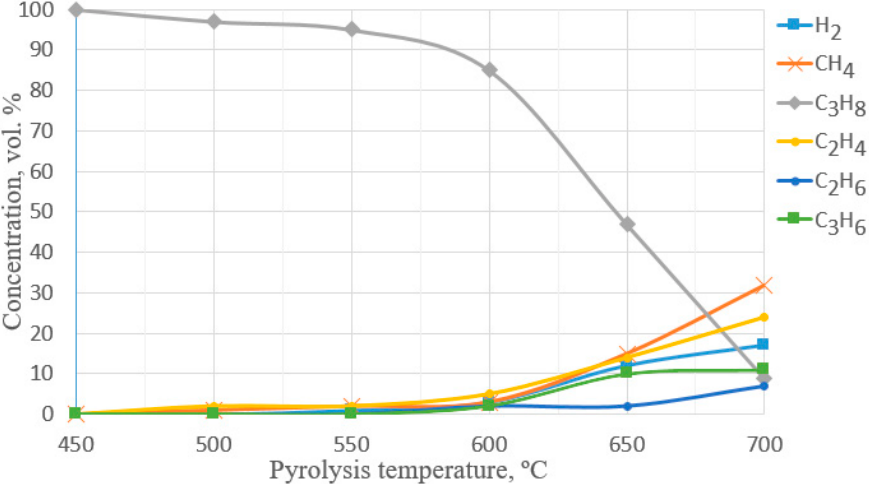
Figure 5. Temperature dependence of the concentration of non-catalytic propane pyrolysis products without a stirrer, the contact time was around 1 s.